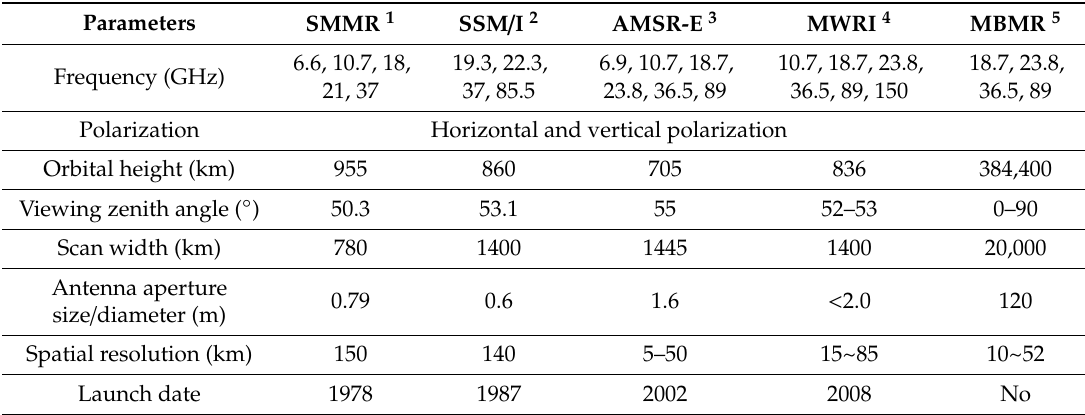
Table 2. The main instrument parameters of the SMMR, SSM / I, AMSR-E, MWRI and